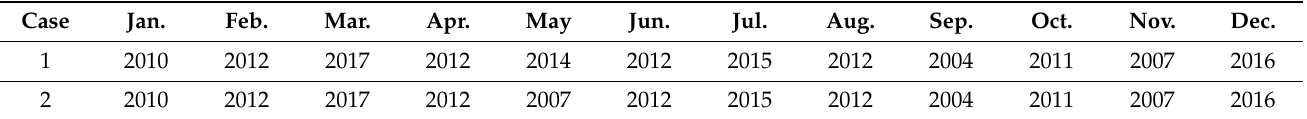
Using this procedure for all months in the study period, a composite year (i.e., the TMY) Table 4. Using the selective TMM for each weather station, as shown in Table 4, the monthly global radiation for each TMM is calculated using the corresponding hourly database for global radiation (available in a publicly accessible repository, http://gitub.com/p47061105/ TaiwanTMY), and the results are listed in Table 5. The respective minimum and maximum global radiation for the 30 weather stations is 3421.8 and 5479.9 MJ / m 2 at the Zhuzihu (Station 2) and Tainan (Station 16) weather stations. Annual global radiation increases from the northeast to the